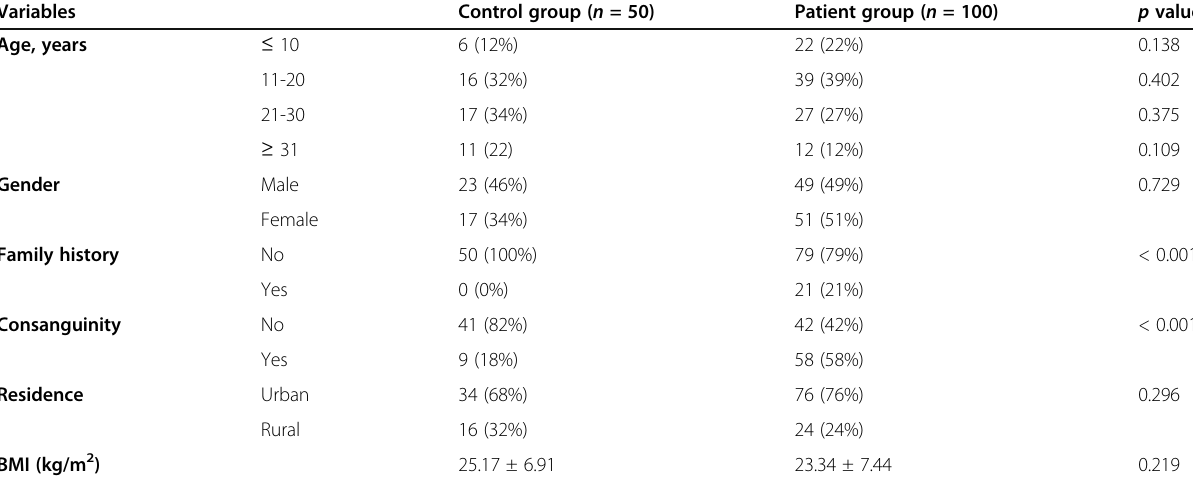
Table 1 Demographic and clinical characteristics of the study population